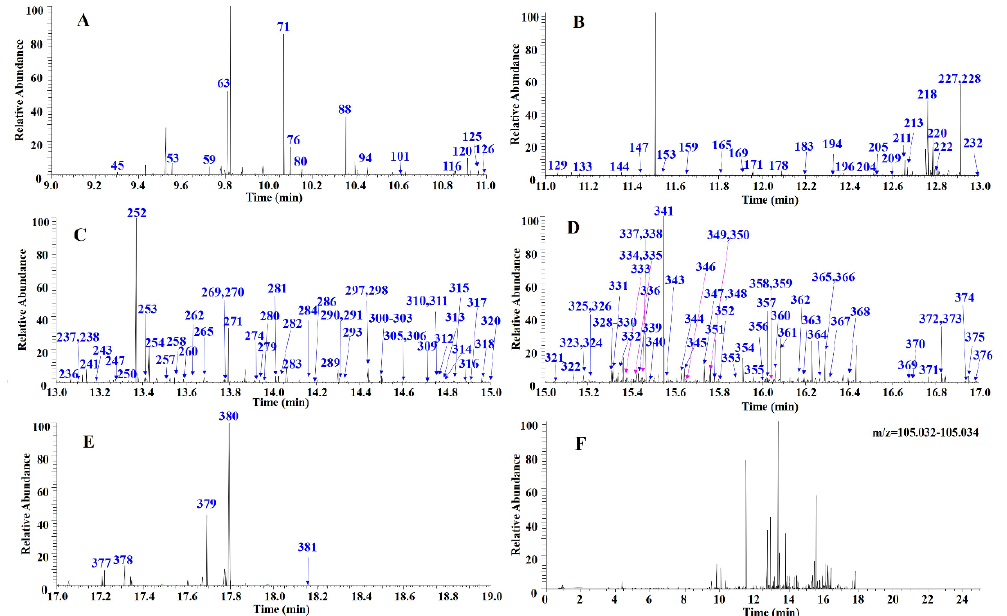
Figure 5. The stepwise DPIs filtering chromatograms of m / z 105.0335 ( F ) with five time-windows set as follows: ( A ) 9.0–11.0 min; ( B ) 11.0–13.0 min; ( C ) 13.0–15.0 min; ( D ) 15.0–17.0 min; ( E ) 17.0–19.0 min.